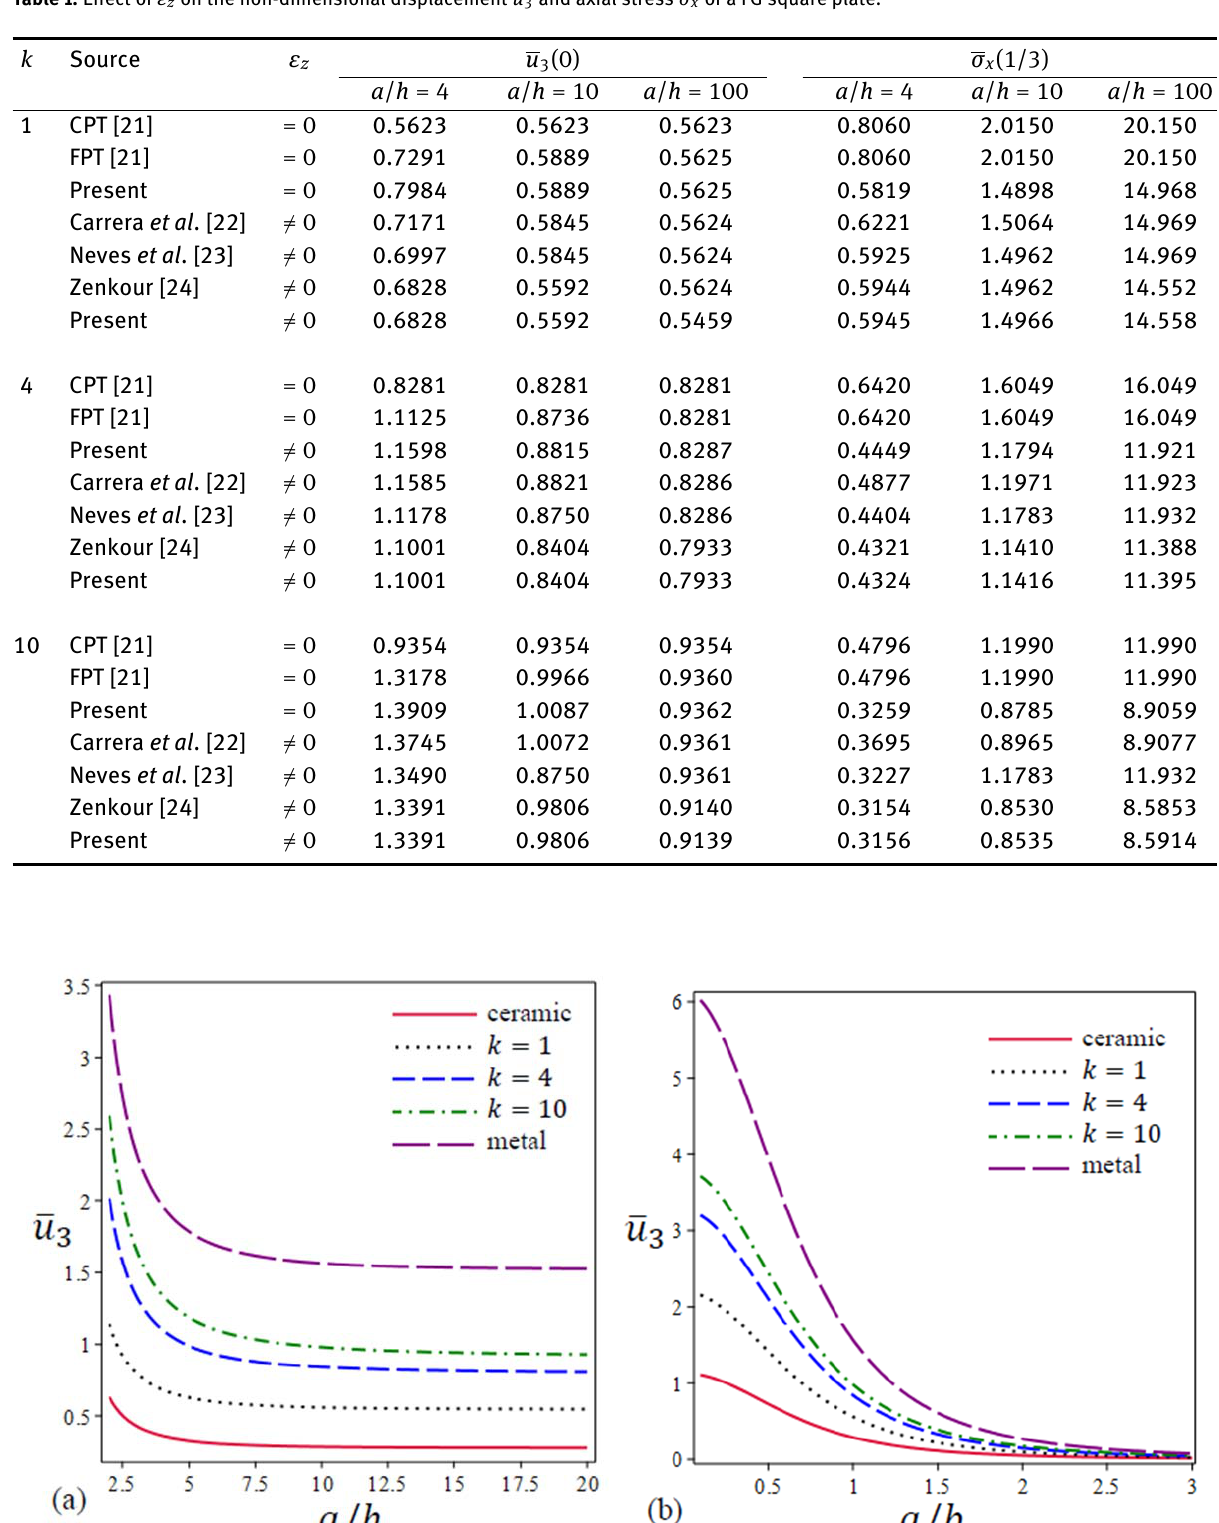
Table 1: Effect of ε z on the non-dimensional displacement u 3 and axial stress σ x of a FG square plate.